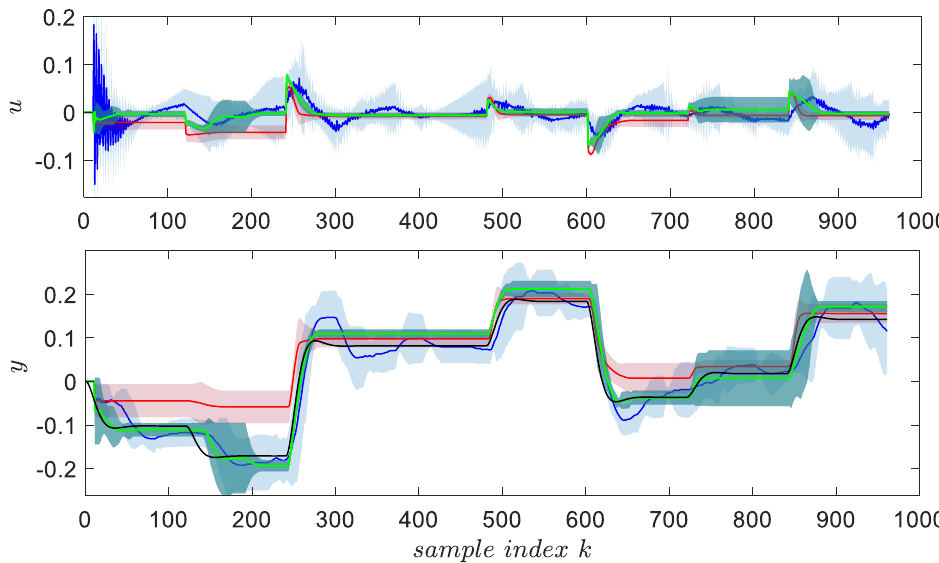
Figure 7. The ORM tracking control experiment with 2DOF (blue), VSFRT (red) and MFVI-RL (green) averaged control performance, with 95% confidence regions. 𝑦 𝑘𝑚 is in black line in bottom subplot.